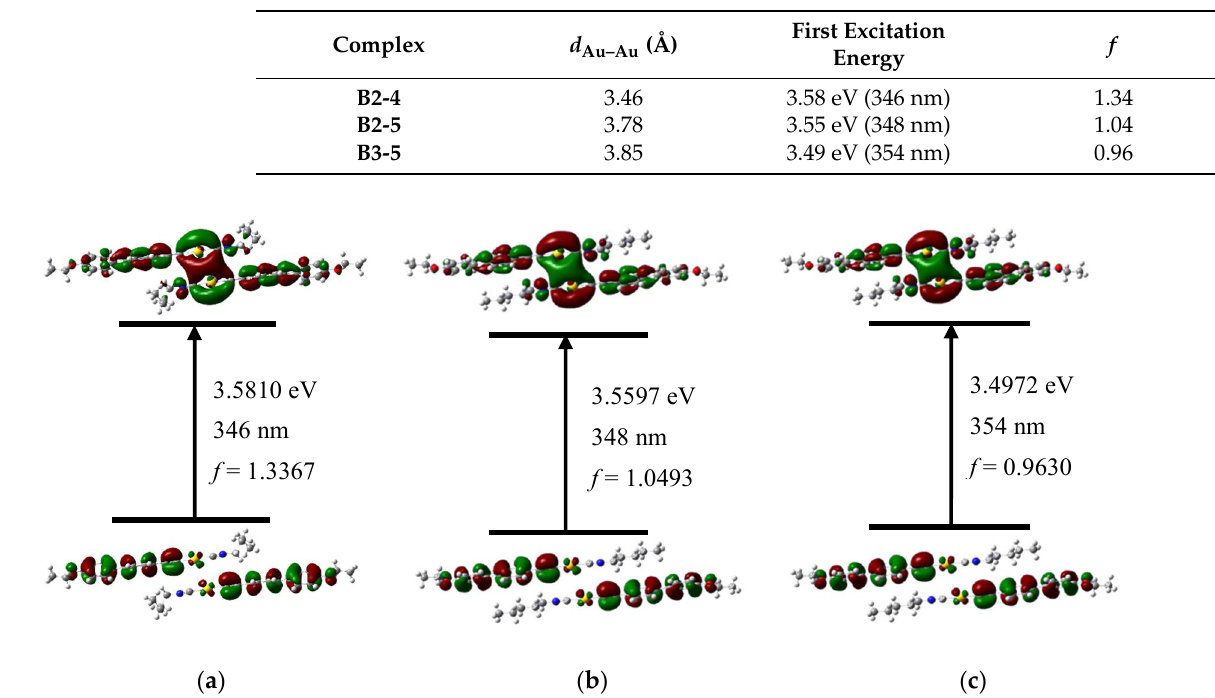
Figure 7. Molecular orbital (HOMO and LUMO), transition energy, excitation wavelength, and oscillator strength ( f ) of the gold(I) complexes ( a ) B2-4 , ( b ) B2-5 , and ( c ) B3-5 obtained by TD-DFT calculations employing B3LYP hybrid functionals with SDD (for the Au atoms) and 6-311 + G(d,p) basis sets for all other atoms. Table 4. TD-DFT results for all gold complexes.